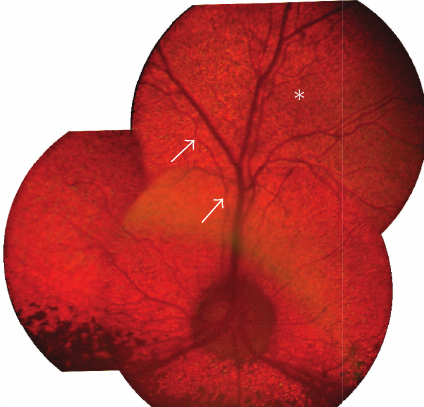
Figure 2: A composite of fundus pictures from a two-year-old ESS dog a ff ected with cone rod dystrophy and homozygous for the RPGRIP1 mutation. The central fundus is mainly normal appearing while an increase in granularity is observed in the midperipheral and peripheral fundus (star). There is also slight vascular attenuation with variable diameter of retinal vasculature